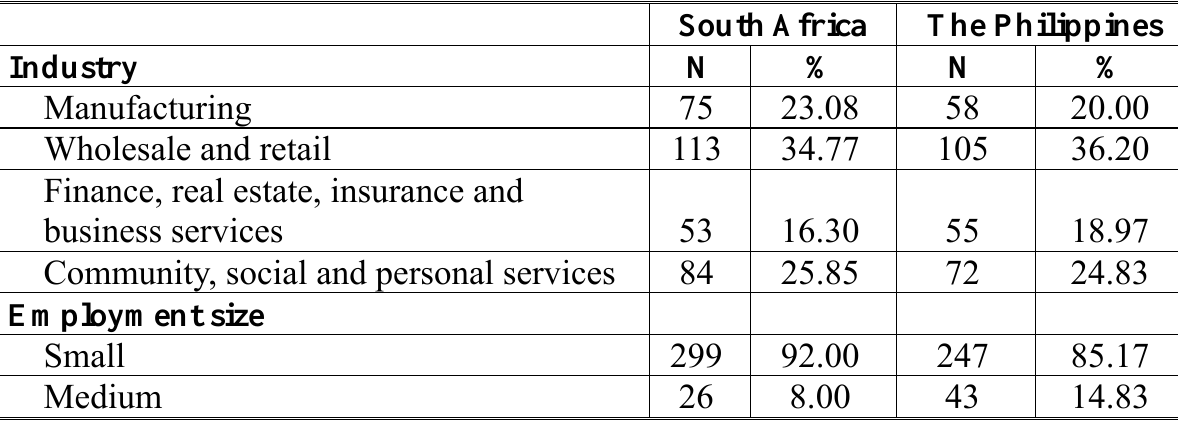
Table 1 Breakdown of sample by industry and size of the firm South Africa The Philippines Industry